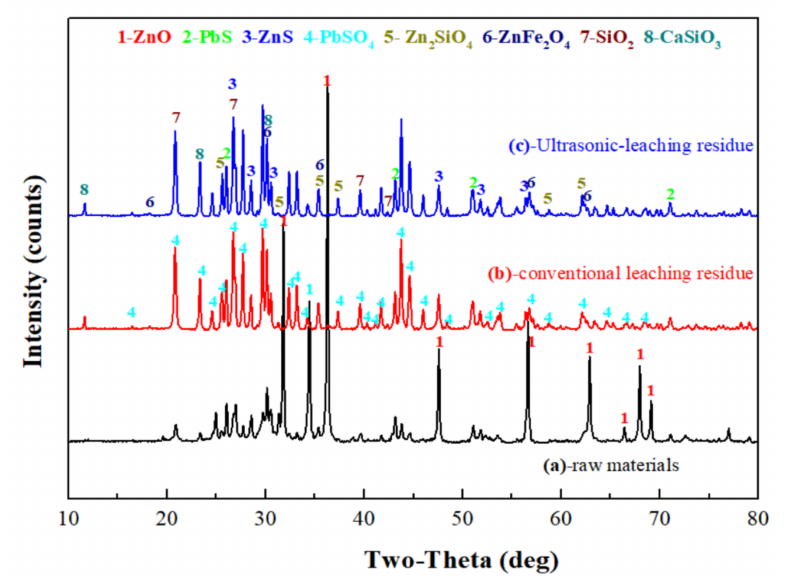
Figure 14. XRD patterns of raw materials ( a ), conventional leaching residue ( b ), and ultrasonic- leaching residue ( c